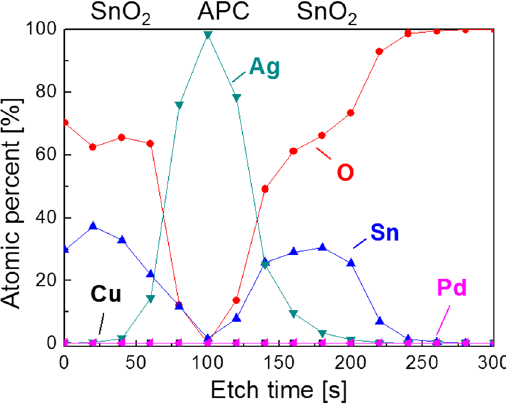
Figure 6. XPS depth profile of the thermally evaporated SnO 2 /APC/SnO 2 multilayer film on a PET substrate.